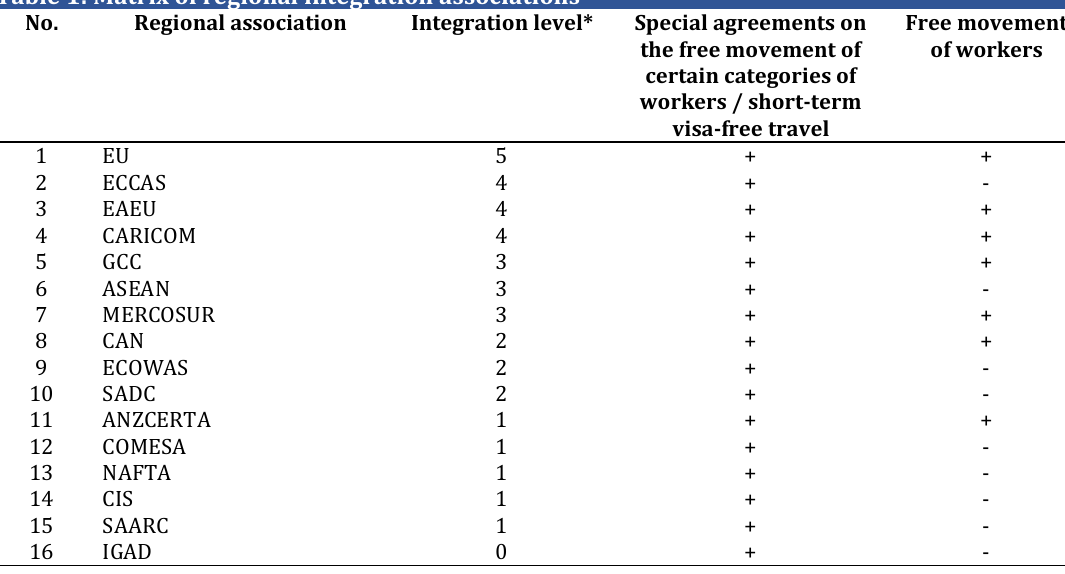
* – integration levels of specific integration associations can combine elements of different levels or exclude theoretically substantiated positions. Positioning according to the levels of integration is based on the prevailing characteristics within the framework of